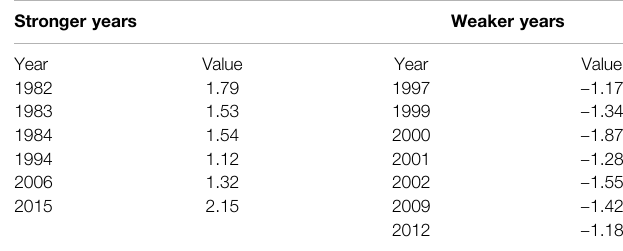
TABLE 1 | The stronger and weaker years in the EOF time series 1 and their corresponding time coef fi cients. Stronger years Weaker years